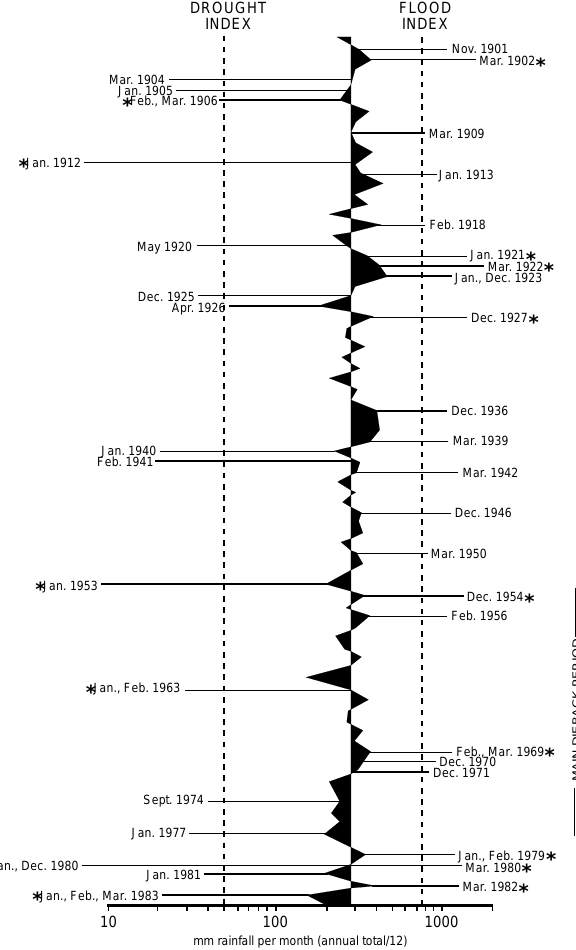
Fig. 8. Extreme rainfall months at Hilo airport from 1900 to 1984. Months with < 50mm (2in.) rain are shown left of drought index and those with > 750mm (30in.) at right of flood index. Months marked with an asterisk ( ∗ ) indicate intense drought or flood events (reproduced with permission from Annual Review of Ecology & Systematics, 17, 231,